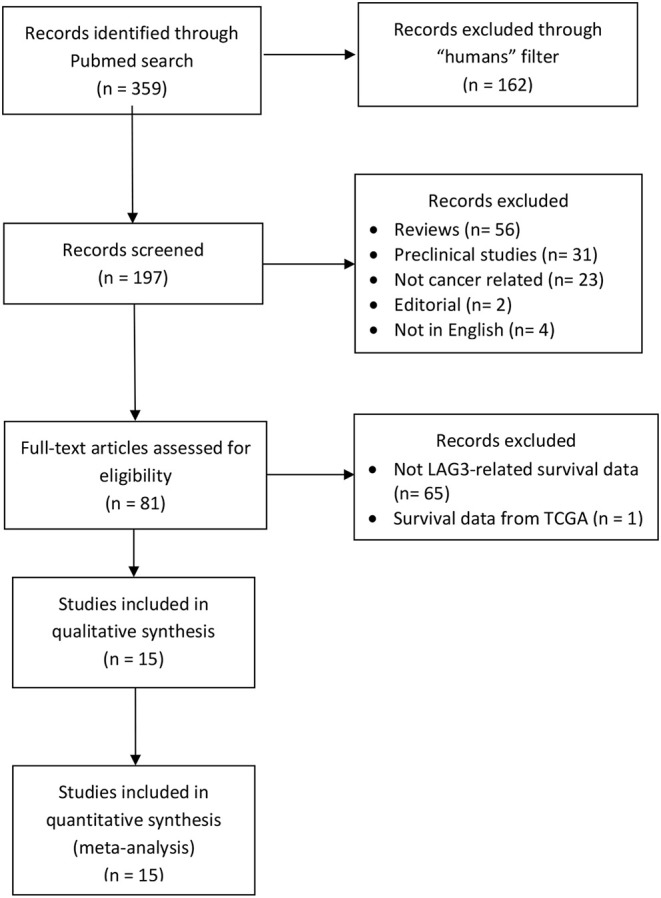
PRISMA of the study selection process for LAG3.